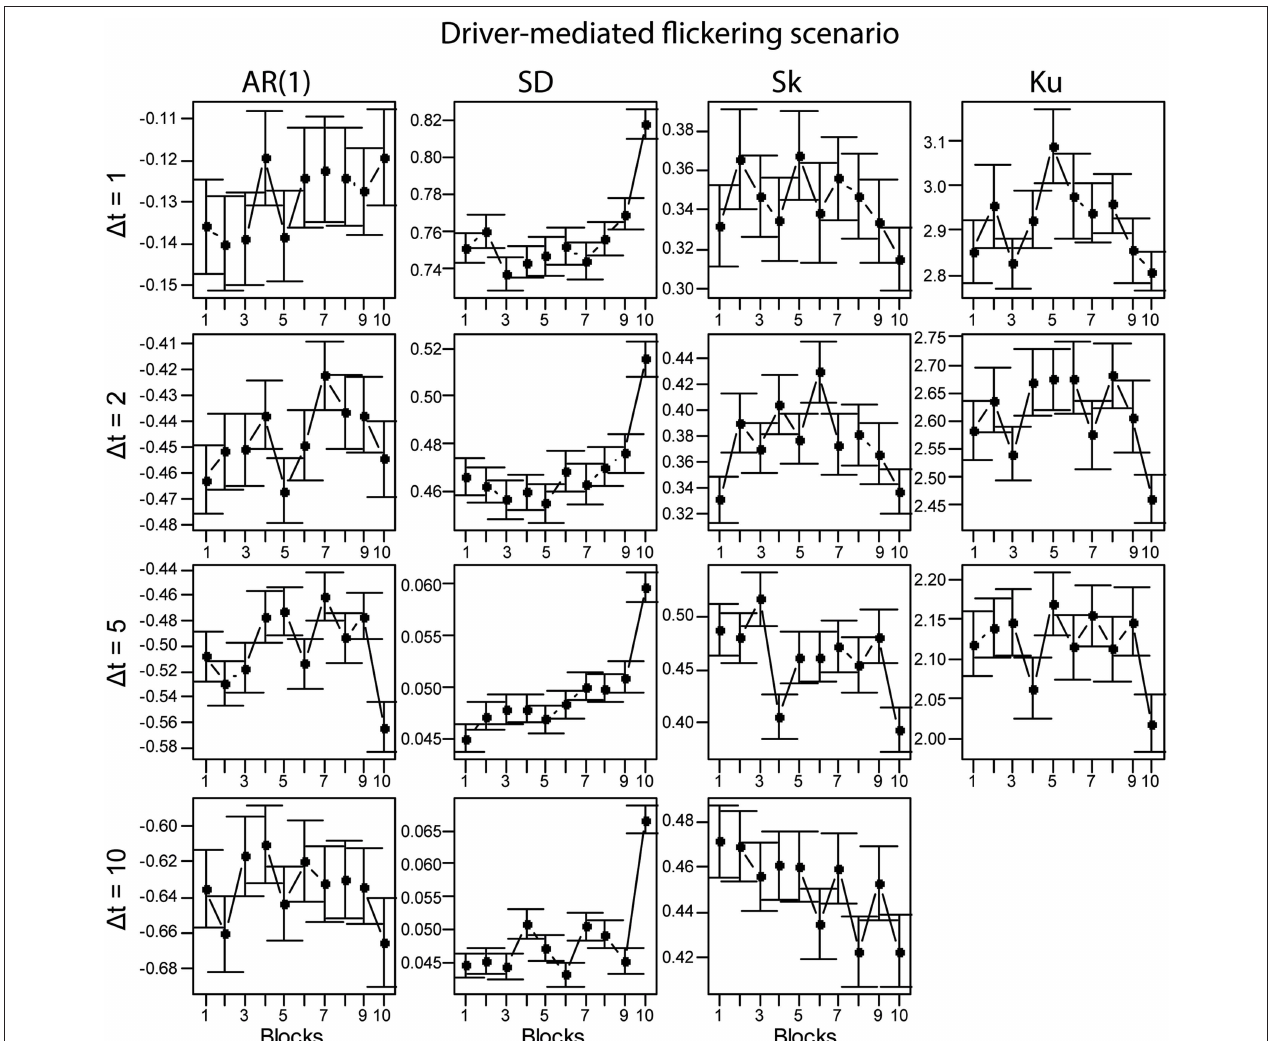
FIGURE 3 | Patterns of four EWSs for the driver-mediated flickering scenario from 200 simulated time series using the block-based approach. Time aggregation ranged from 1 t = 1 to 1 t = 10. Black circles associated with whiskers represent mean values and standard errors of EWSs. As time scale is reversed, the transition occurs at the end of the 10th block. AR(1), autocorrelation; SD, standard deviation; Sk, skewness; Ku, kurtosis. Kurtosis could not be computed for aggregation 1 = 10 because of the lack of data for each block ( n = 3 ) for this aggregation